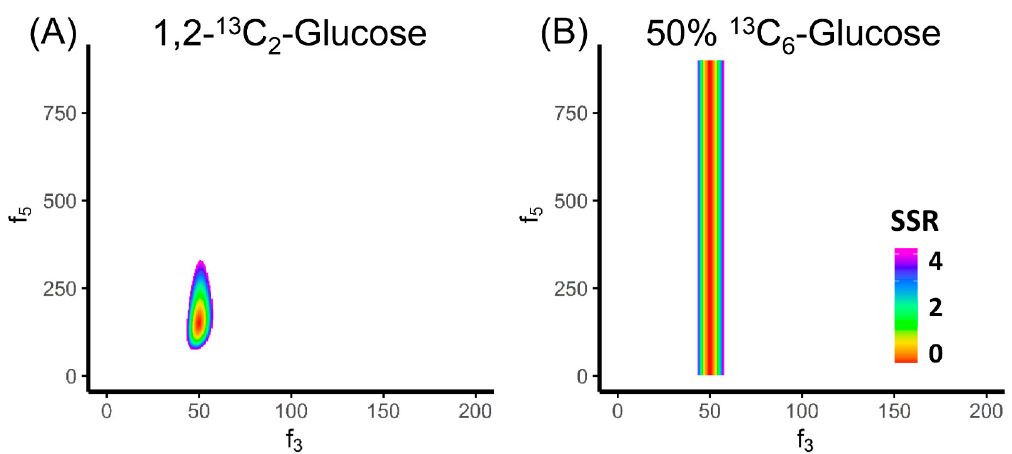
Figure 3. Evaluation on the tracer selection for MFA. ( A ) The colored region is showing the 95% confidence region of f 3 and f 5 using 1,2- 13 C 2 glucose as tracer, assuming 1% error on all labeled fractions of FBP. Both f 3 and f 5 can be relatively well-determined. ( B ) The colored region is showing the 95% confidence region of f 3 and f 5 using 50% U- 13 C- glucose + 50% unlabeled glucose as the tracer. Only f 3 can be determined.